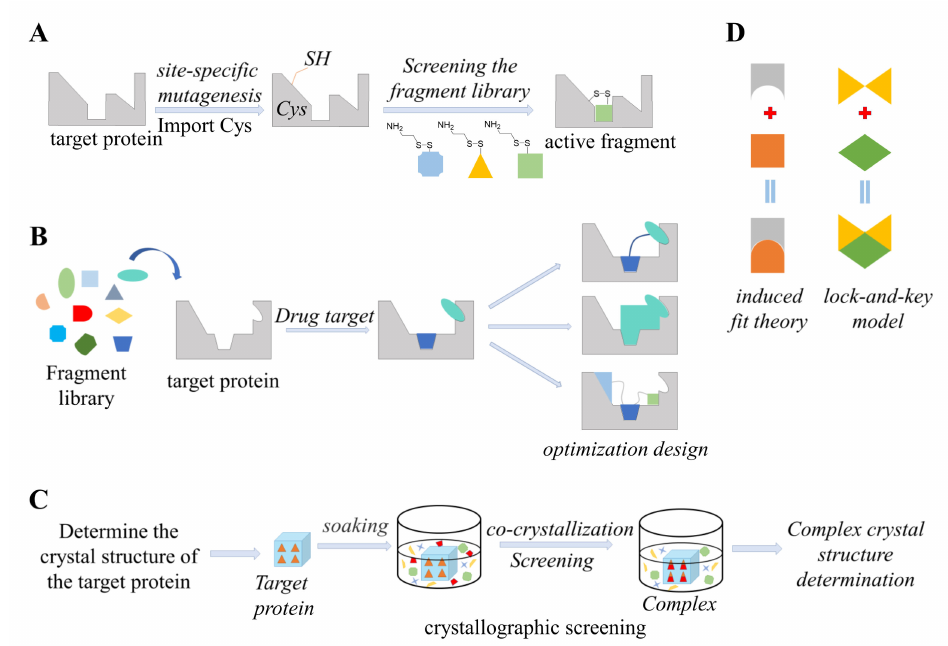
Figure 6. Illustration of structure − guided analysis methods. ( A ) Principles of tethering. First, experimentalists investigate whether there are endogenous cysteine residues near the active pocket of the target protein. If not, cysteine residues are introduced by site-directed mutagenesis. Then, the fragments in the fragment library are all attached to the same sulfhydryl side chain, and the target protein is placed in a high-concentration solution of the fragments. In the solution, the formation and dissociation of disulfide bonds between the fragments and target proteins reach a dynamic equilibrium and active pockets form stable fragment–target protein covalent